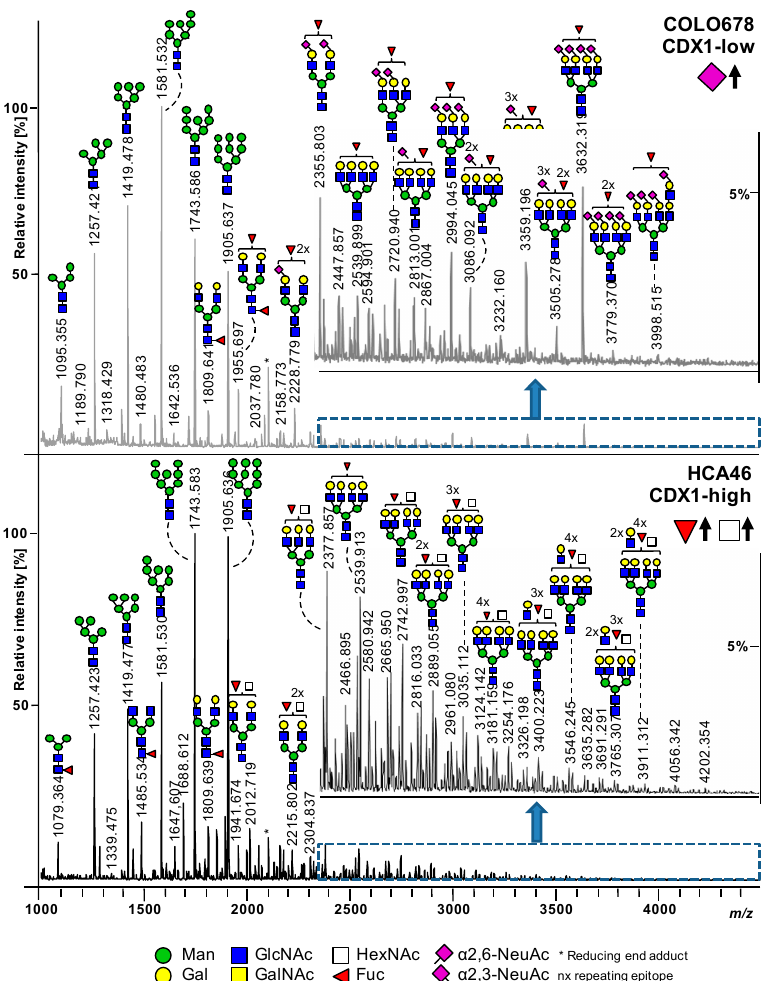
Figure 2. Exemplary MALDI-TOF-MS spectra. MALDI-TOF-MS spectrum of CDX1-low expressing cell line COLO678 (upper spectrum), and of CDX1-high expressing cell line HCA46 (lower spectrum). Spectra were recorded in positive ion reflectron mode on a Bruker UltrafleXtreme mass spectrometer. On the y-axis, the relative intensity is given with 100% corresponding to the highest peak in each spectrum. The spectrum range of m/z 2350 to m/z 4600 is enlarged in the inset. Main peaks are annotated with glycan cartoons, representing compositions, and the presence of additional structural isomers cannot be excluded. To simplify the cartoons, repeating epitopes are indicated as “nx”. Green circle = mannose, Man; yellow circle = galactose, Gal; blue square = N -acetylglucosamine, GlcNAc; white square = N -acetylhexosamine, HexNAc; red triangle = fucose, Fuc; purple diamond = sialic acid, N -acetylneuraminic acid, NeuAc. Differences in N -acetylneuraminic acid linkages are indicated using different